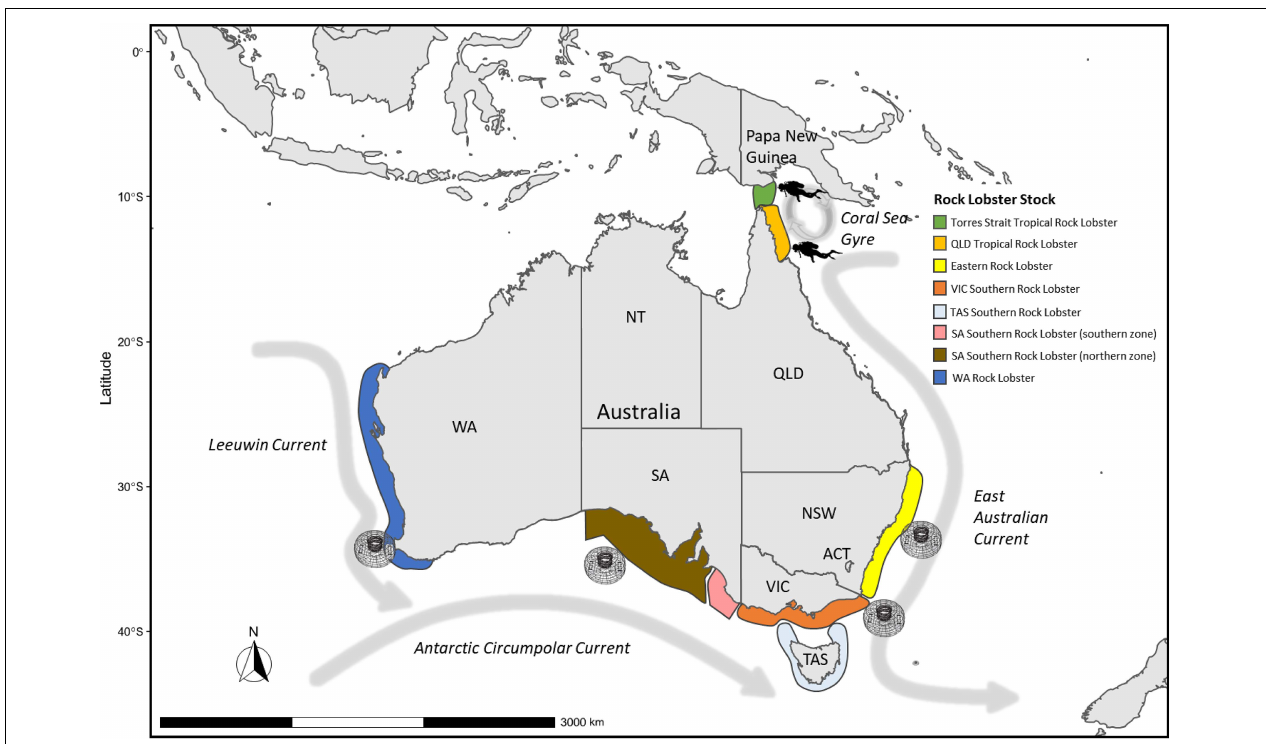
FIGURE 1 | Map of Australia and Papua New Guinea showing location of the Torres Strait tropical rock lobster dive fishery and linked Queensland (QLD) tropical lobster fishery as well as the six other major lobster trap-based fisheries as summarized in Plagányi et al. (2018), namely Eastern rock lobster Sagmariasus verreauxi , southern rock lobster Jasus edwardsii from Victorian (Vic), Tasmania (Tas), South Australia (SA) southern and northern zones and West Australia rock lobster P. cygnus